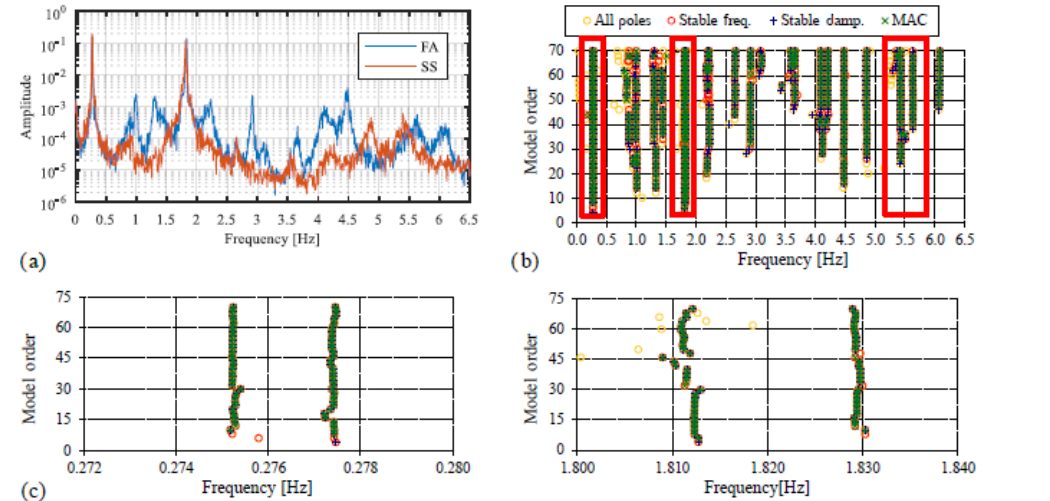
Figure 4. Ambient-vibration test results for wind turbine 1: (a) average power spectra for FA and SS directions, (b) stabilization diagram produced by the SSI-COV method, (c) two enlargements of the stabilization diagram to show the two pairs of tower-bending modes.